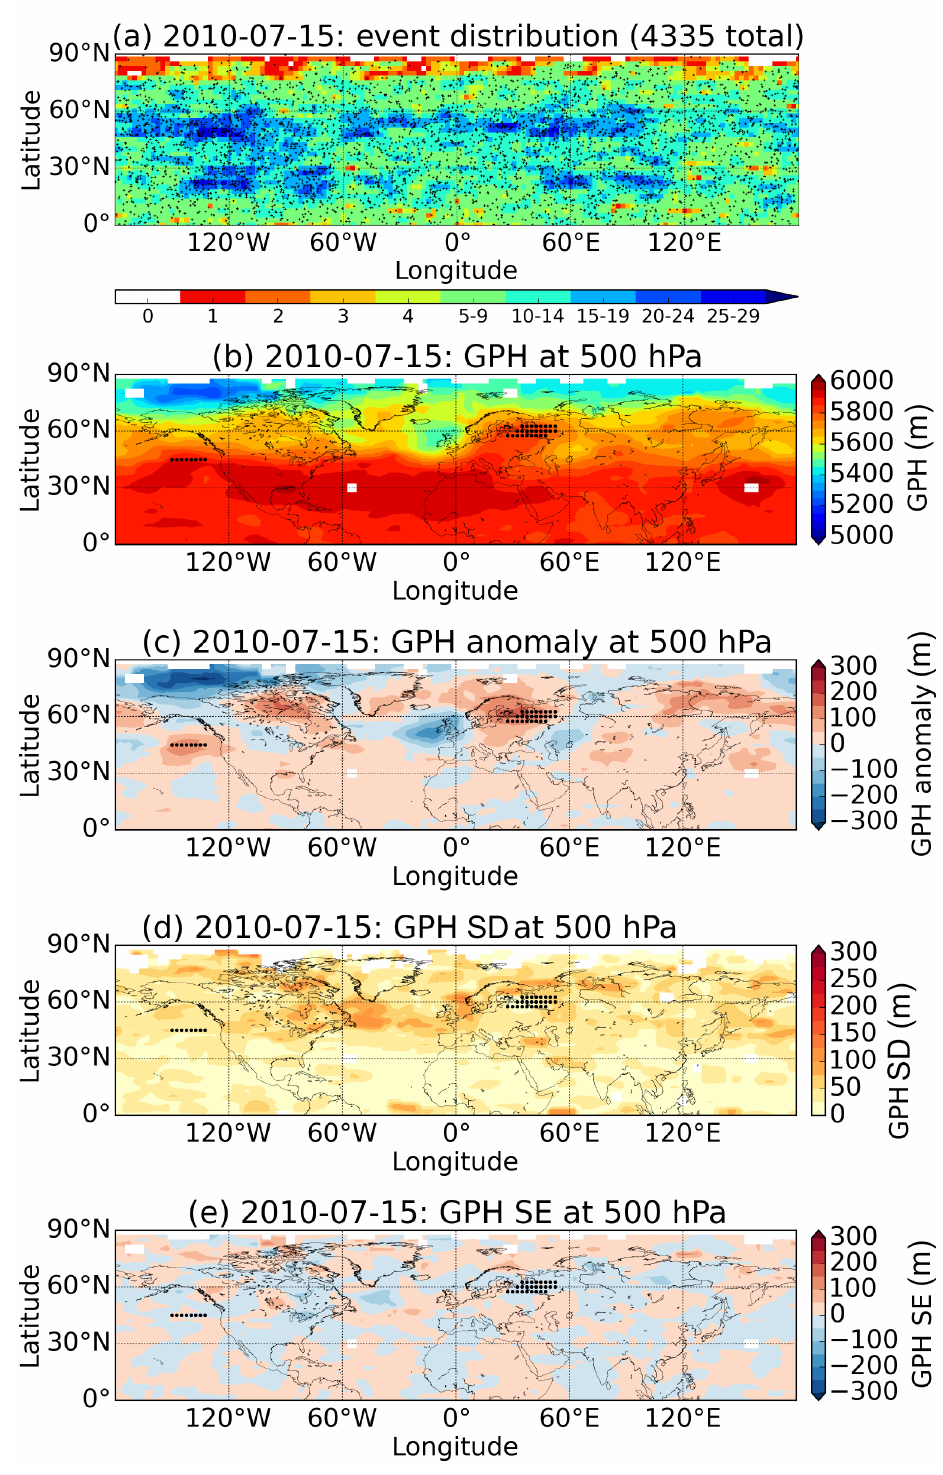
Figure 1. Panel (a) : RO event distribution (plus signs) in the NH for an exemplary day ( ± 2 neighboring days) during the Russian blocking and number of events per grid cell (shading). Other panels: geographic maps at 500hPa of (b) GPH, (c) GPH anomaly relative to the mean from 2006 to 2013, (d) standard deviation of individual profiles, and (e) sampling error. Blocked grid cells are indicated by dots; missing data are